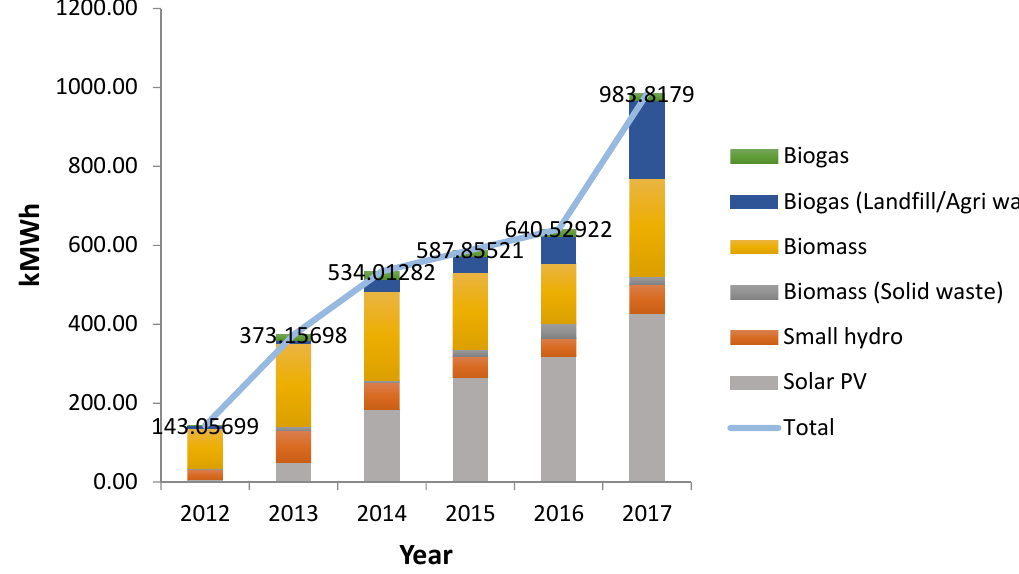
Figure 4. Annual power generation (kMWh) of commissioned RE installations (2012–2017) (source: Sustainable Energy Development Authority Malaysia [23]).